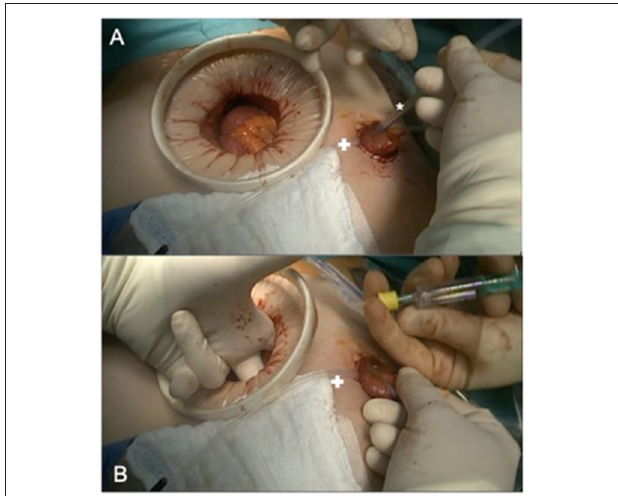
FIGURE 2 | Intraoperative colonic irrigation via ileostomy. (A) Placing the catheter (*) in the efferent loop ( + marking a loop, fixing the diverting stoma until fixation is completed. (B) Blocking the catheter under manual controll before starting the antegrade colonic irrigation.